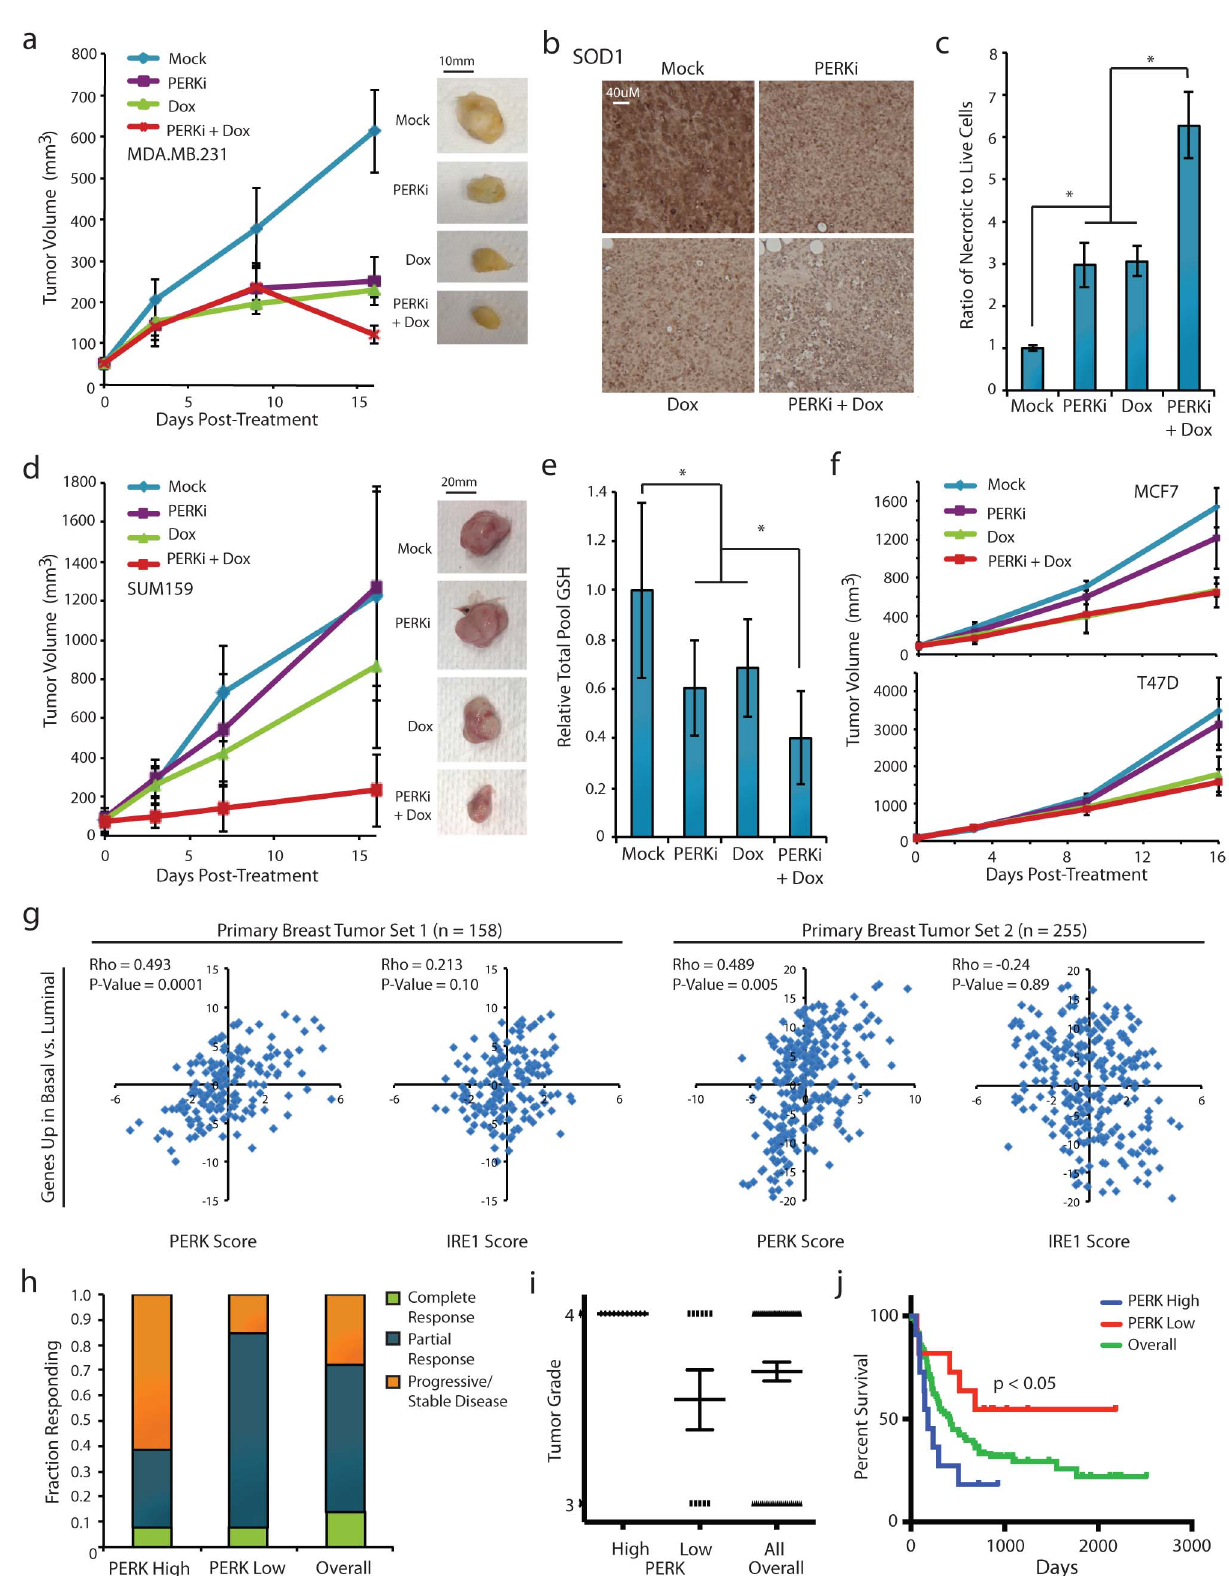
Figure 5. PERK promotes chemotherapy resistance in vivo and correlates with tumor de-differentiation in patient samples. (a) MDA.MB.231 cells were injected bilaterally into the mammary fat pads of female NOD/SCID mice. After reaching 60–80 mm 3 , tumors were treated with PERKi (7.5 mg/kg/tumor) or DMSO by intratumoral injection, and Dox (2.5 mg/kg) or PBS by intraperitoneal (IP) injection according to the